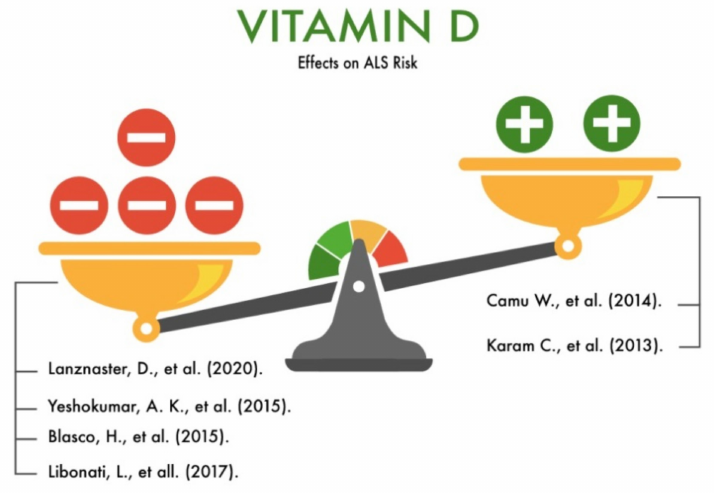
Figure 10. The effect of vitamin D on the risk of developing amyotrophic lateral sclerosis